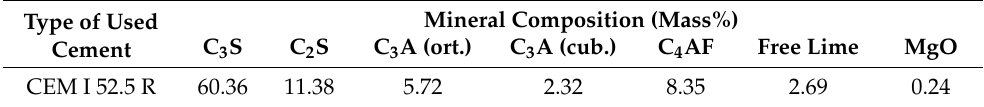
Table 3. Mineral composition of CEM I 52.5 R given by producer. Type of